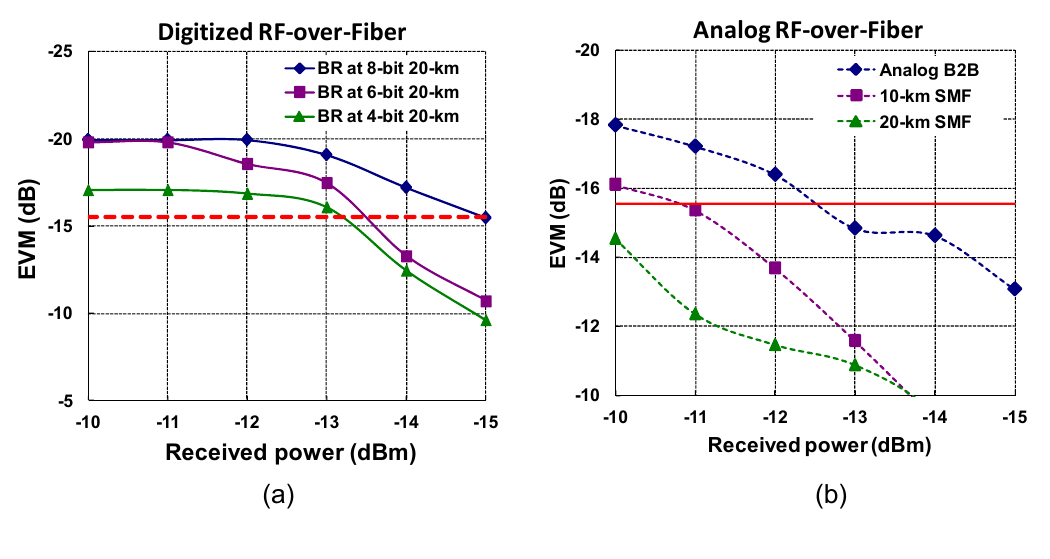
Figure 5. Error vector magnitude measured for ( a ) digitized RF-over-fiber transport and ( b ) analog RF-over-fiber transport over 20 km of fiber. © [2008] IEEE. Reprinted, with permission, from IEEE OSA Lightwave Technology,